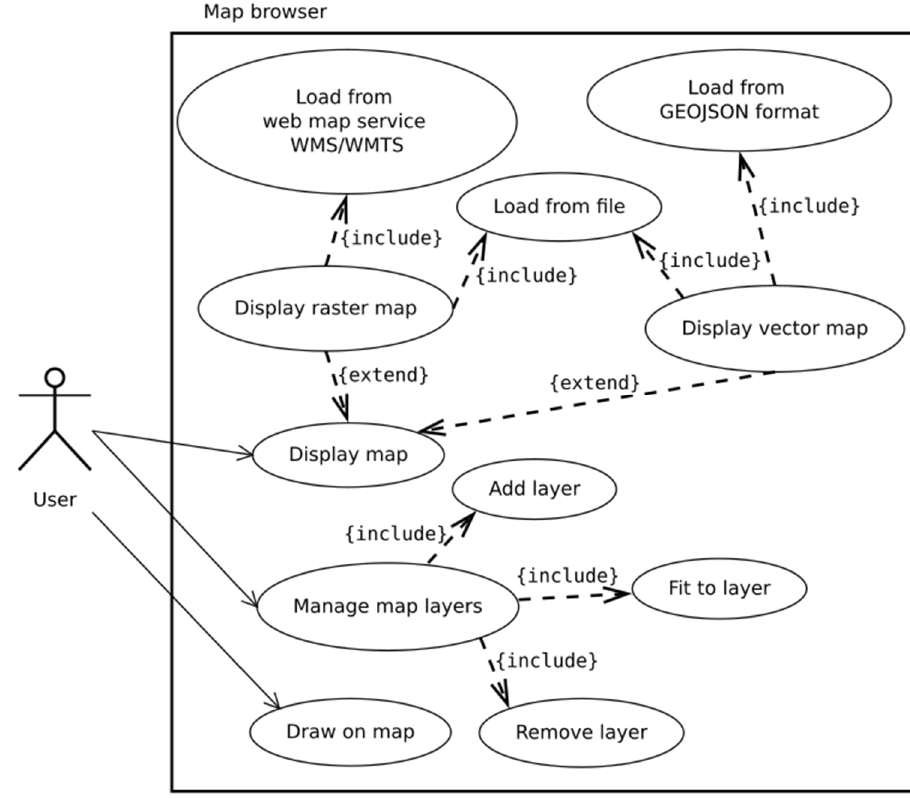
Figure 9. Map browser use case diagram.